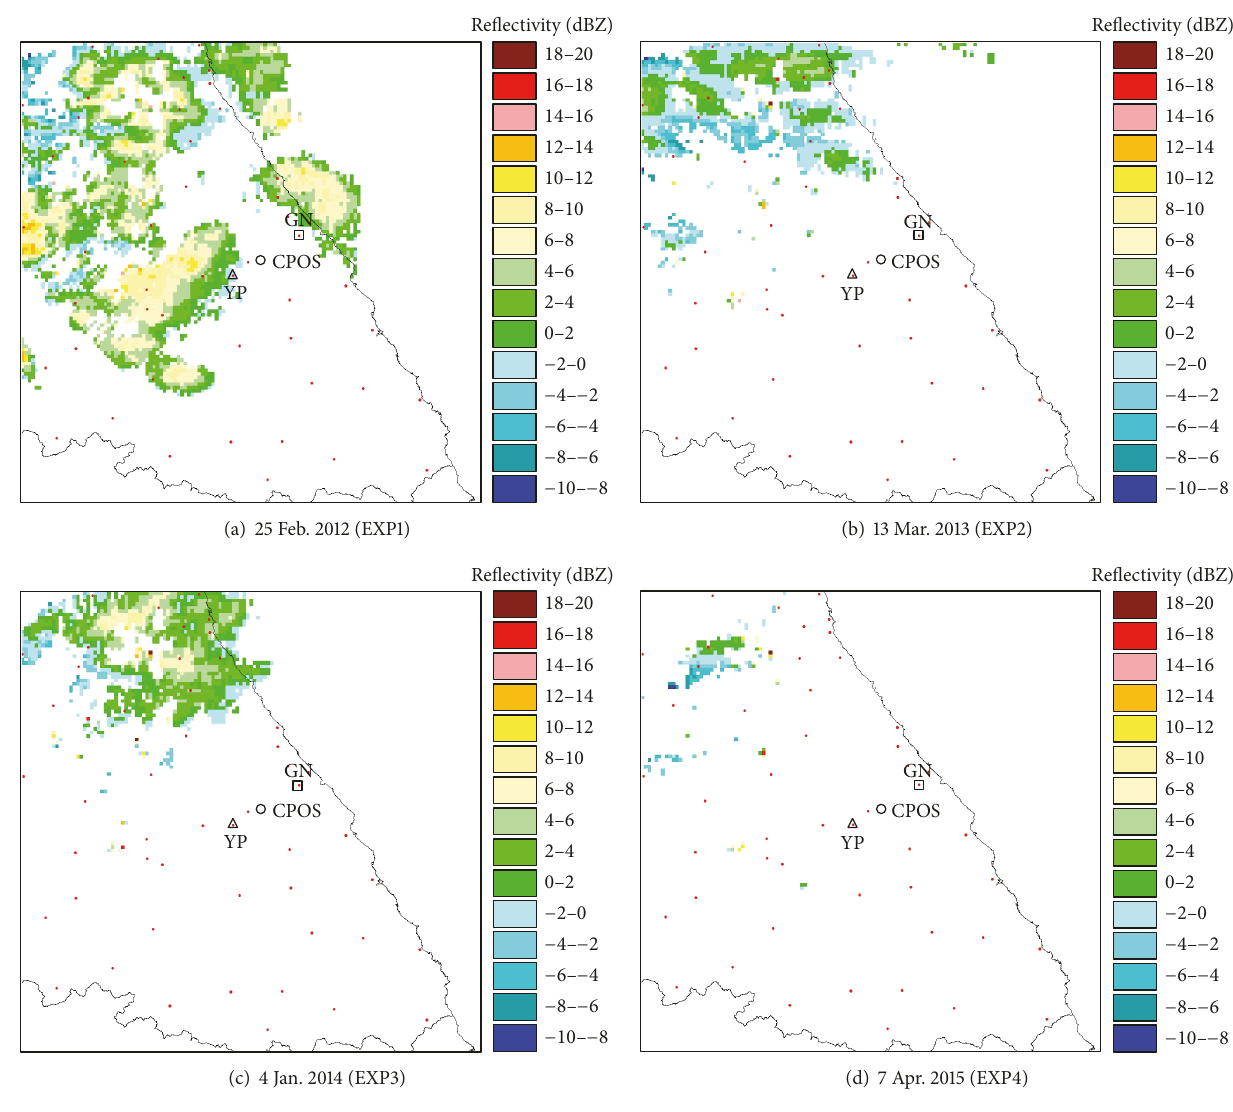
Figure 10: The 1h averaged composite reflectivity of PPI0 after the start of seeding from the Korea Meteorological Administration ground- based operating radars for (a) EXP1, (b) EXP2, (c) EXP3, and (d) EXP4. The red dot indicates the automatic weather station